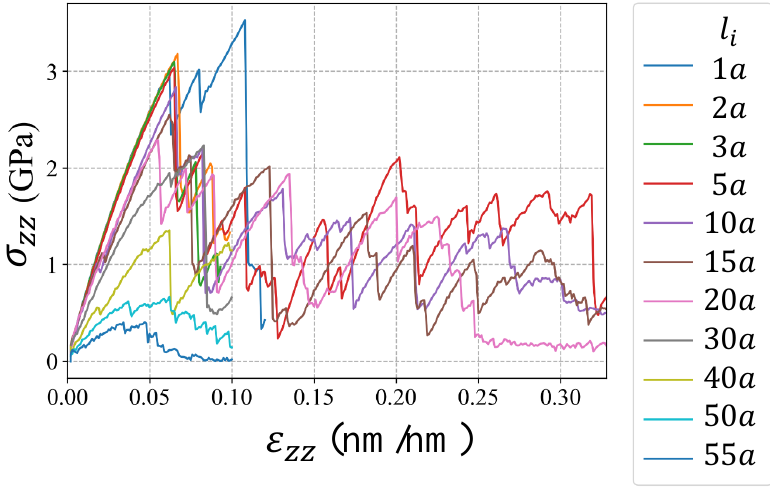
Figure 4. Simulation results of tensile tests for bi-crystals Al with different l i